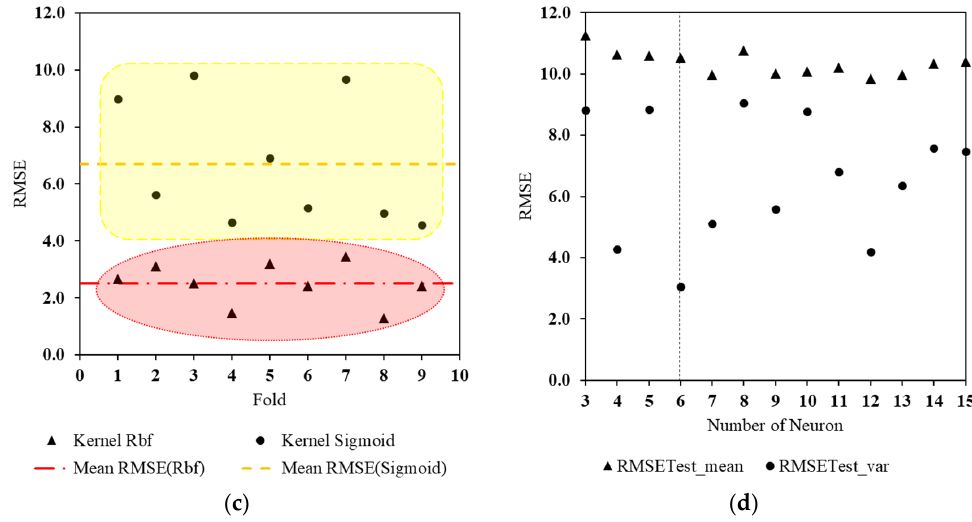
Figure 5. Evaluation of regression models (( a ) KNN, ( b ) polynomial, ( c ) SVR, ( d ) MLP), for different ranges of parameters using the mean and variance of RMSE for the test data—WWTP A.